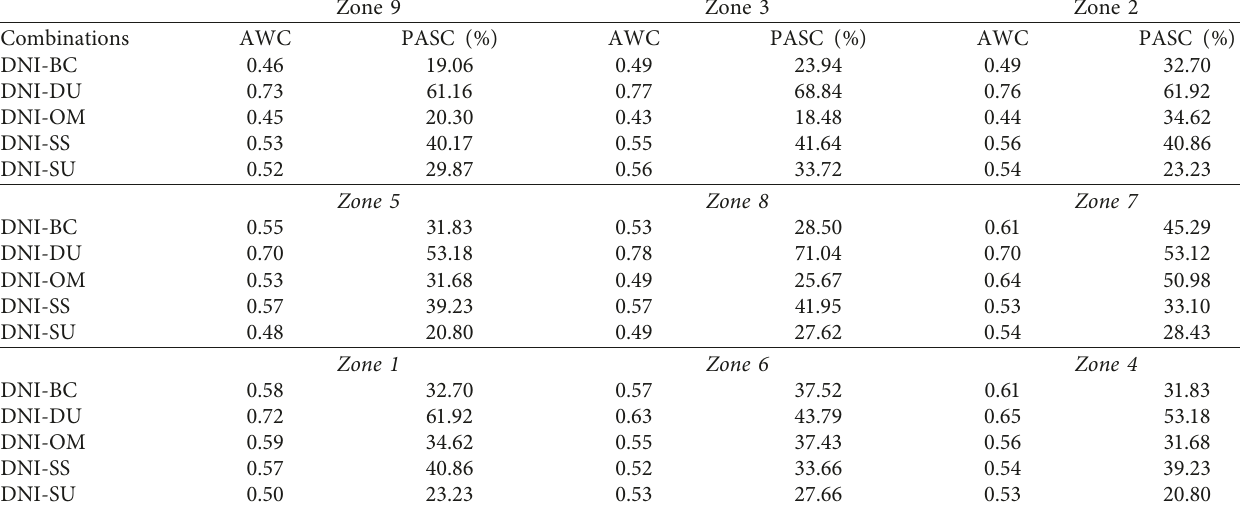
Table 1: Average wavelet coherence (AWC) and the percentage of the significant power (PASC) values for wavelet coherence analysis of all the 9